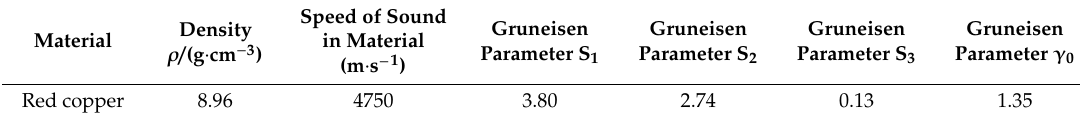
Table 2. Red copper calculation parameters.